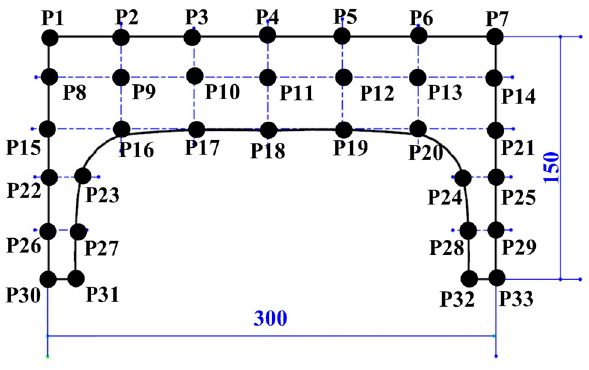
Figure A1: Deformation measurement